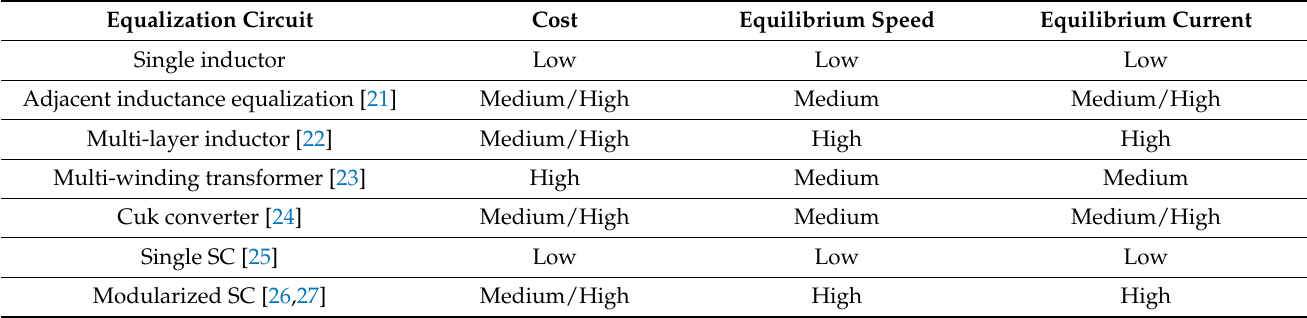
Table 1. Equalization circuit performance